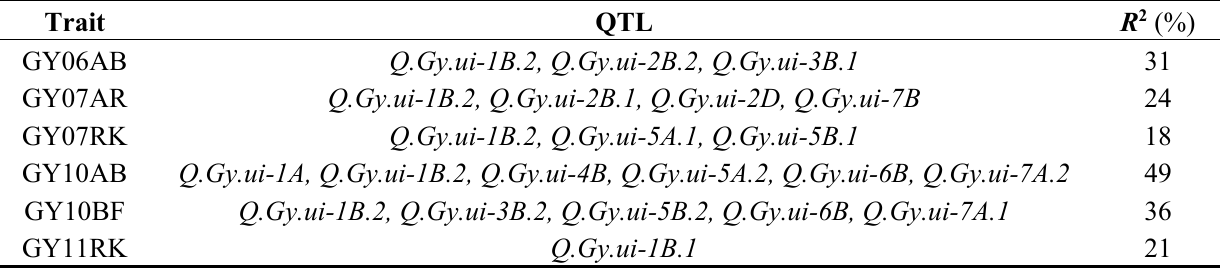
Table 8. Total phenotypic variation ( R 2 ) explained by all the QTL for grain yield in each trial.